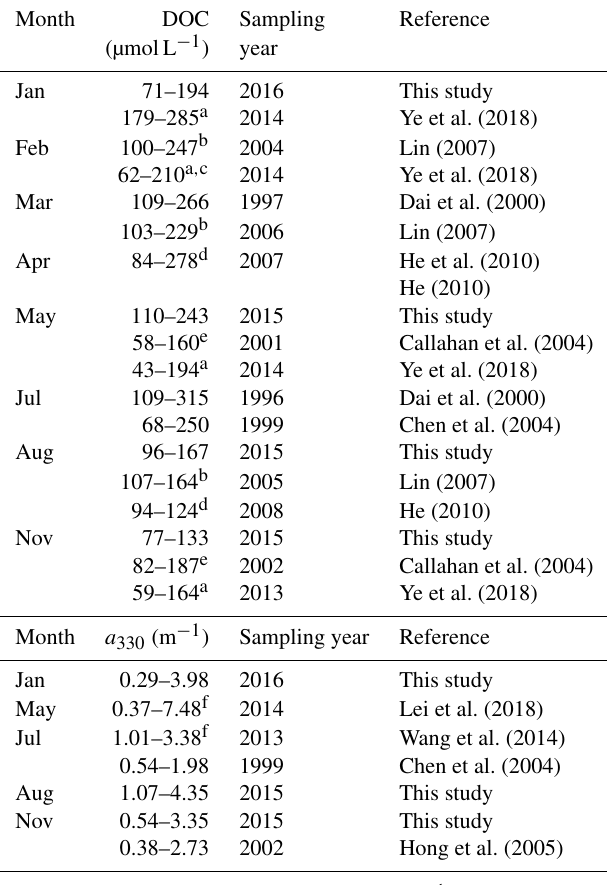
Table 2. DOC concentrations and a 330 in surface water of the Pearl River estuary reported in the literature and this